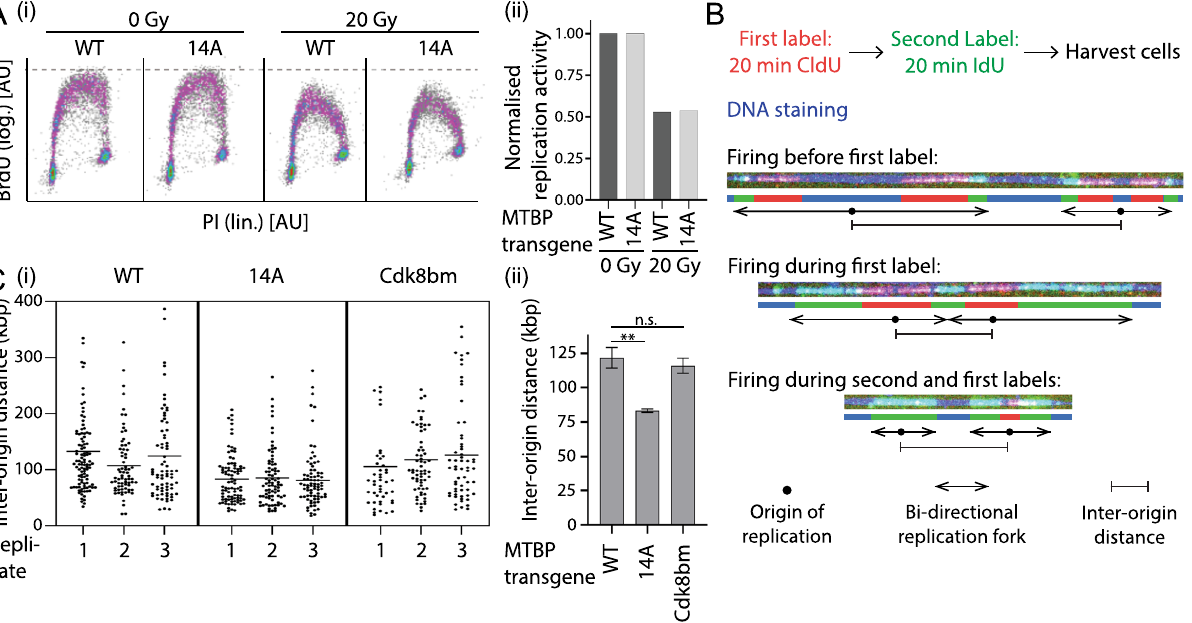
Figure 4. Phosphorylation of MTBP at checkpoint kinase consensus sites inhibits origin firing in unperturbed cell growth conditions. ( A ) Flow cytometry PI-BrdU density plots of HeLa Flip-In T-Rex cells expressing siMTBP resistant C-terminally 3xFlag-TEV2-GFP-tagged MTBP-wild type (WT) or MTBP-14A treated with siMTBP, doxycycline, irradiated with 0 Gy or 20 Gy, and stained as in 2C. (i), density plots and (ii) quantification of replication signals, involving normalisation to cells irradiated with 0 Gy. Log., logarithmic scale; lin., linear scale; [AU], arbitrary units. Significance tests as in 2D/E. ( B , C ) Inter-origin distance measured by DNA combing of siMTBP-treated Hela Flip-In T-Rex cells expressing siMTBP resistant C-terminally 3xFlag-TEV2-GFP-tagged MTBP-wild type (WT), MTBP-14A or MTBP-cdk8bm. C(i), scatter plots of individual experiments; C(ii), quantifications of respective means; kbp, kilobasepairs. Error bars: SEM; n = 3; significance tests as in 2D/E. See also Supplementary Information Fig.